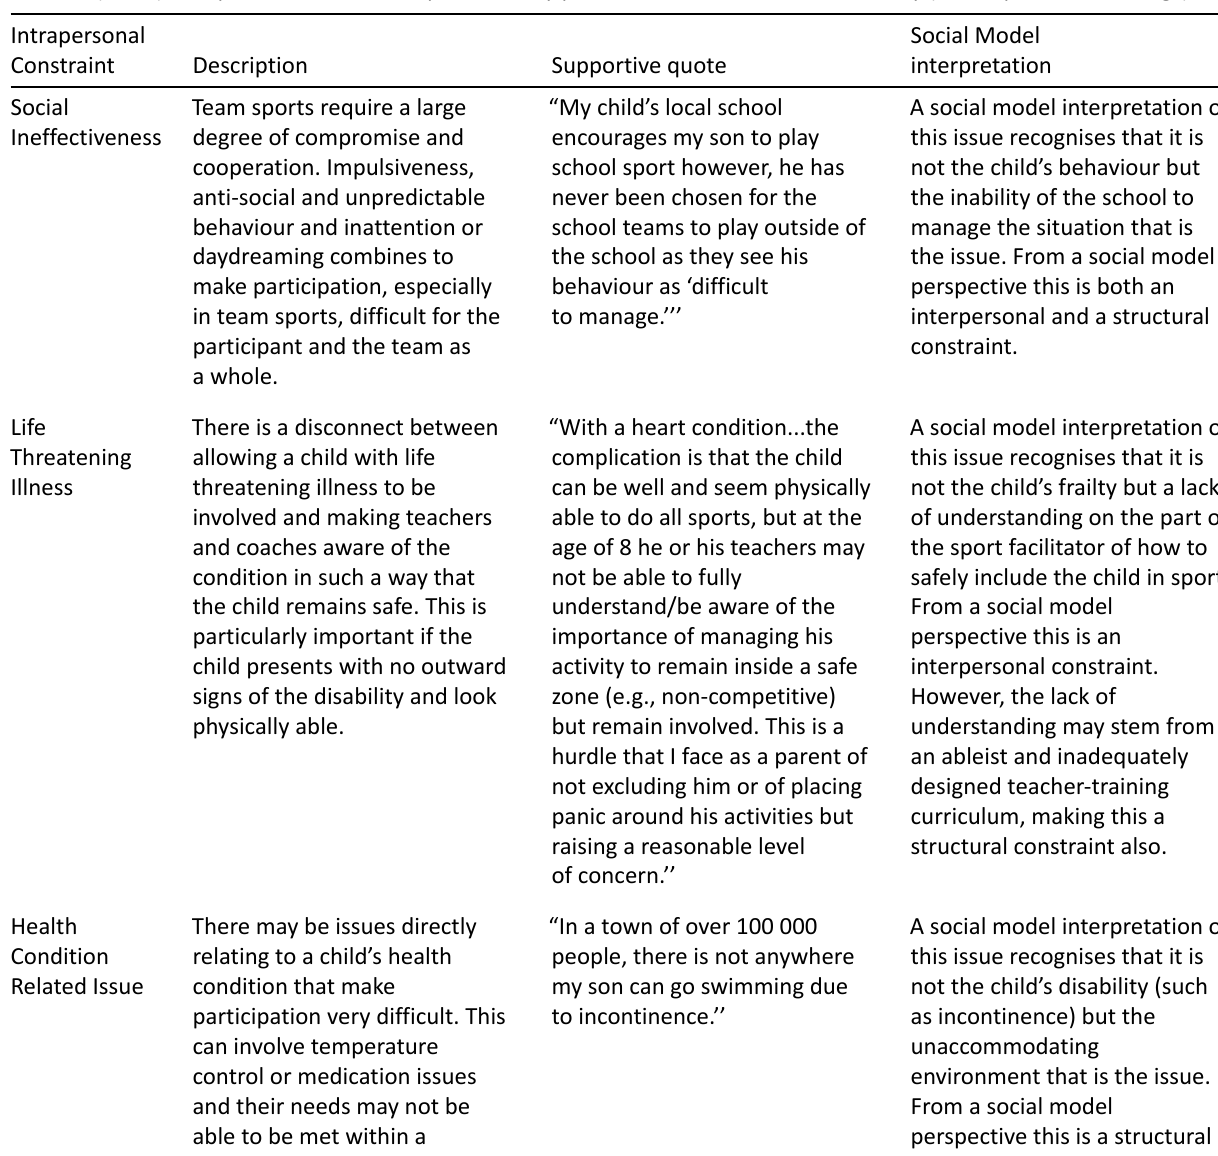
Table 2. (Cont.) Intrapersonal constraints perceived by parents with children with disability (developed from